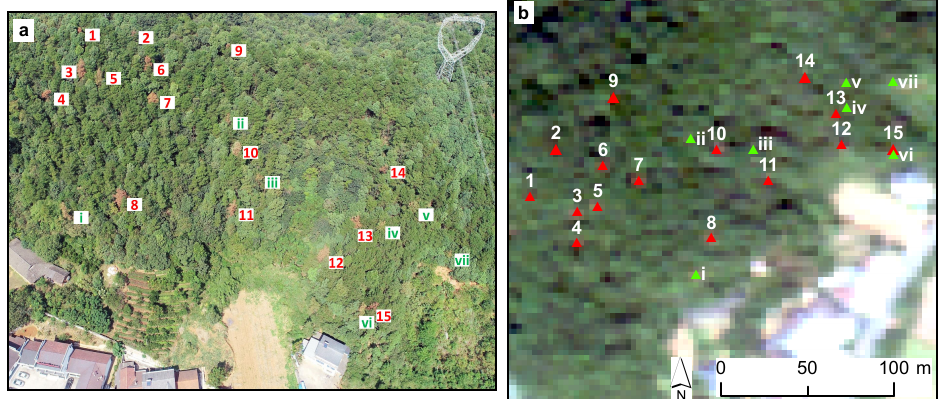
Figure 2. The locations of the wilted pine trees (marked with Arabic numerals) and discolored deciduous trees (marked with Roman numerals) on ( a ) the UAV photo and ( b ) the satellite image at Site A. The canopy widths of the Nos. 2, 9, and 15 trees were less than 3 m, and the No. 14 pine tree was mostly blocked by the adjacent